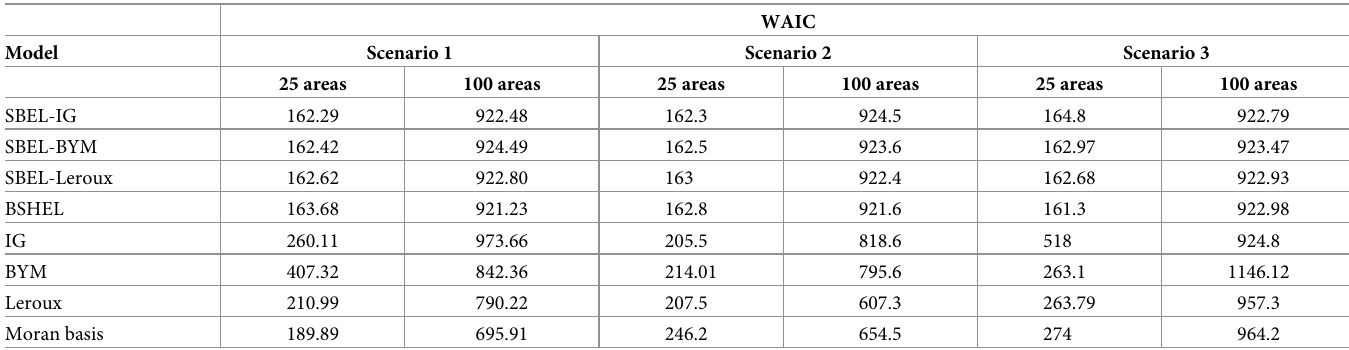
models for all periods. It can be seen from Fig 8 that the log of new deaths per million (response variable) does not follow a normal distribution; which explains the comparatively poor performance of the parametric models which rely on this assumption. This result also supports the observations in the simulated data application about the better performance of SBEL models under situations in which the underlying parametric assumptions of the response variables are not satisfied. In terms of comparison of model performances in each period for the COVID-19 application, it is observed that the SBEL-BYM model had the small- est WAIC throughout the three periods.